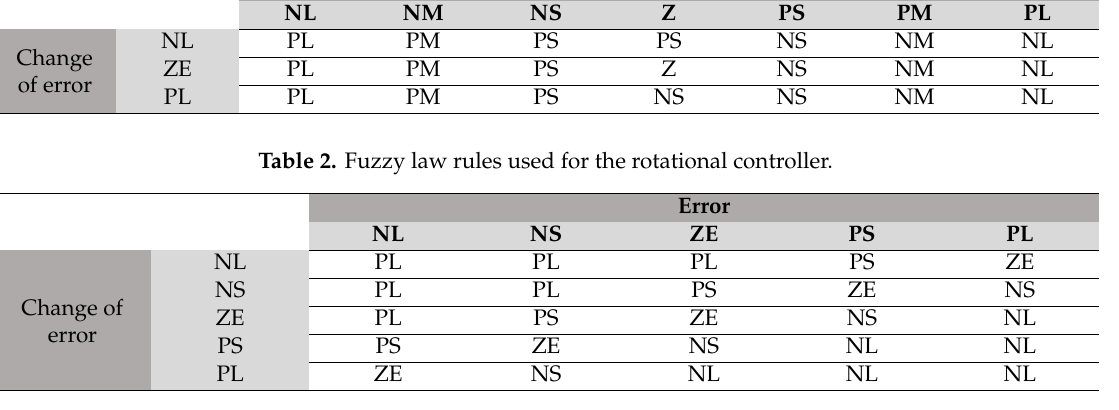
Table 2. Fuzzy law rules used for the rotational controller.